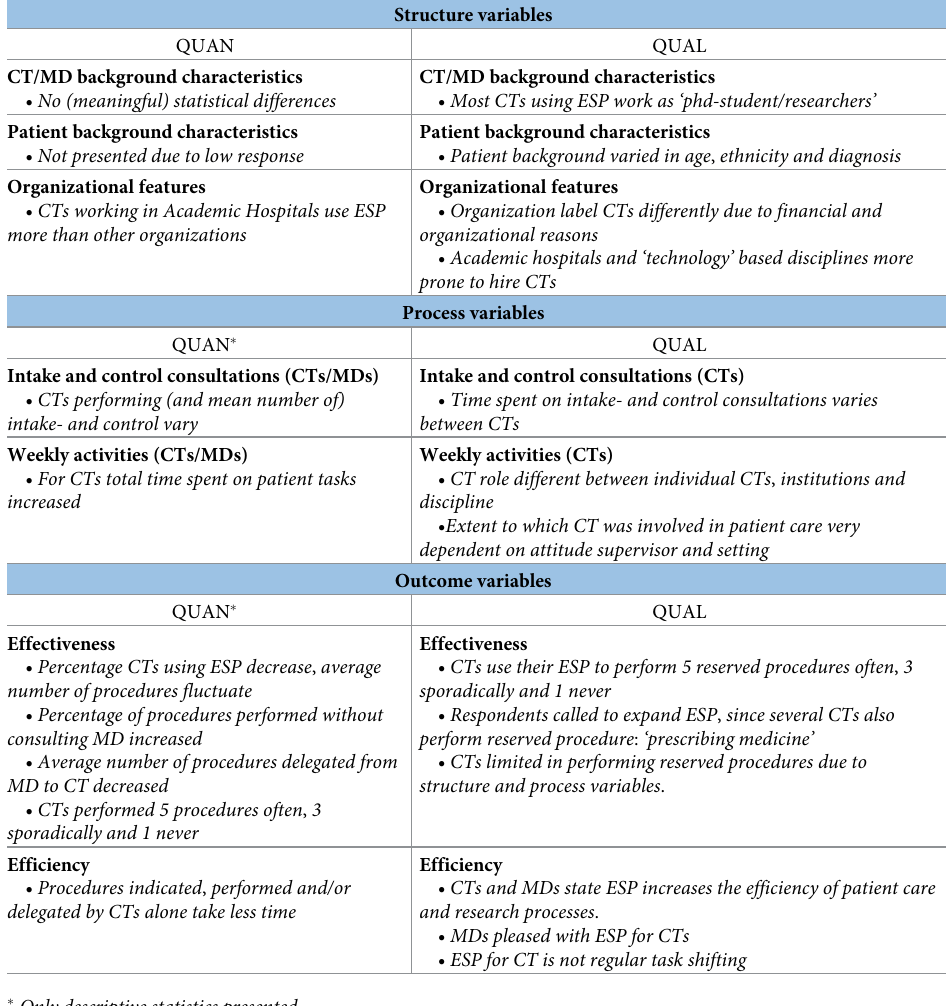
Table 6. Summarized results